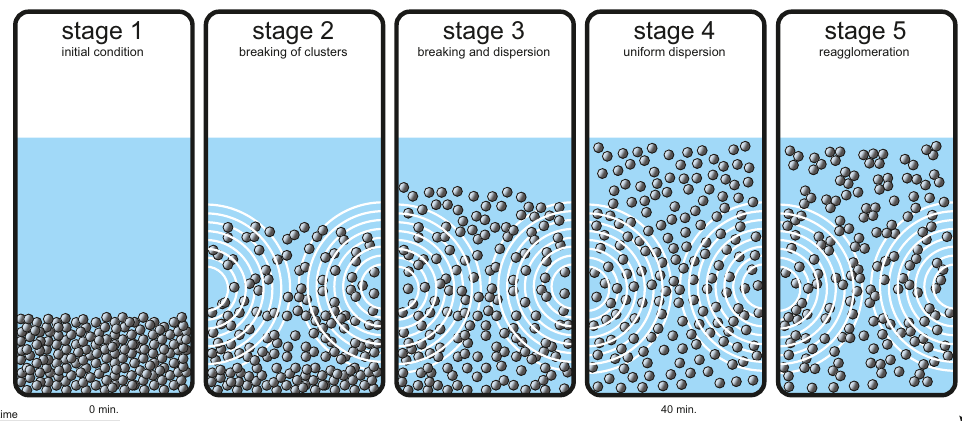
Figure 7. Various stages of nanofluid during